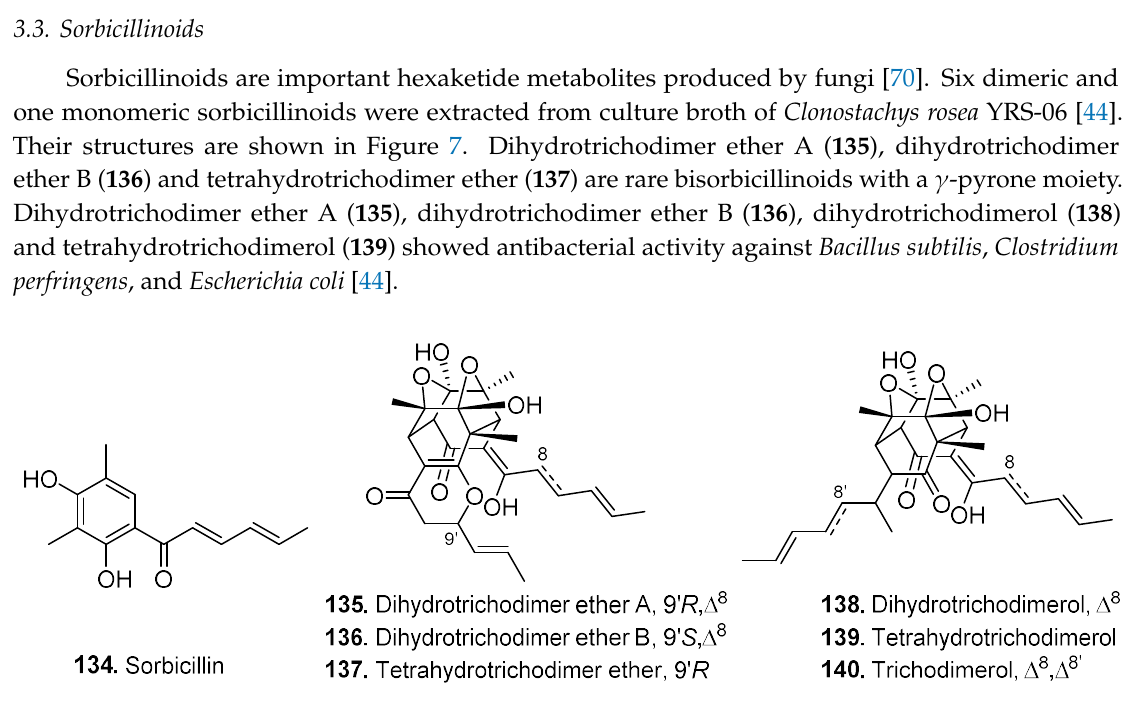
Figure 7. Sorbicillinoids isolated from Clonostachys fungi.